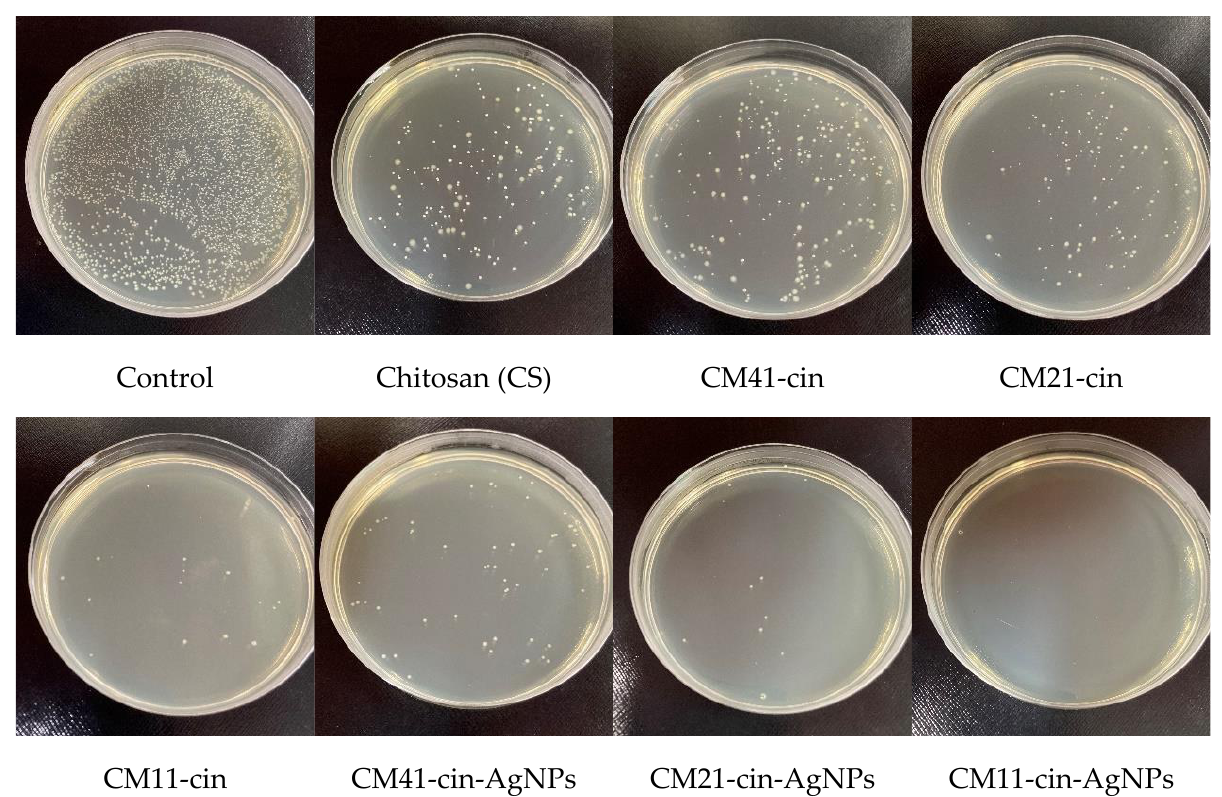
Figure 6. The representative agar plate image of viable S. aureus counts after 6 h of contact with different hydrogels.